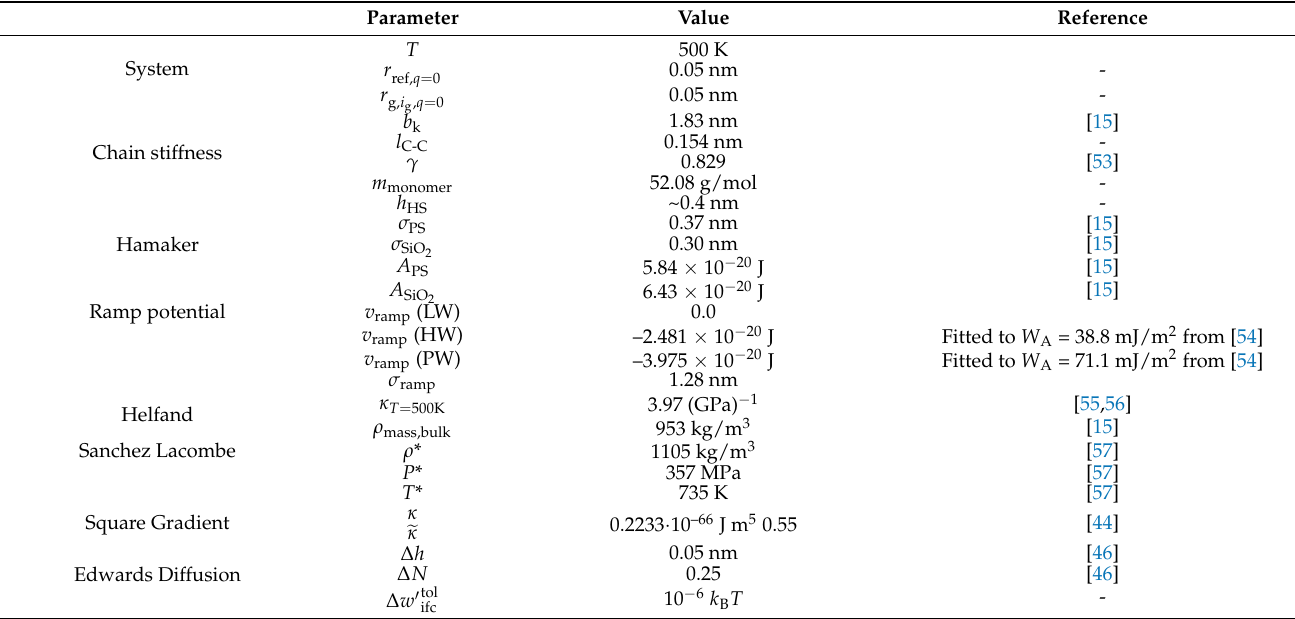
Table 1. Parameters of the self-consistent field theory (SCFT)